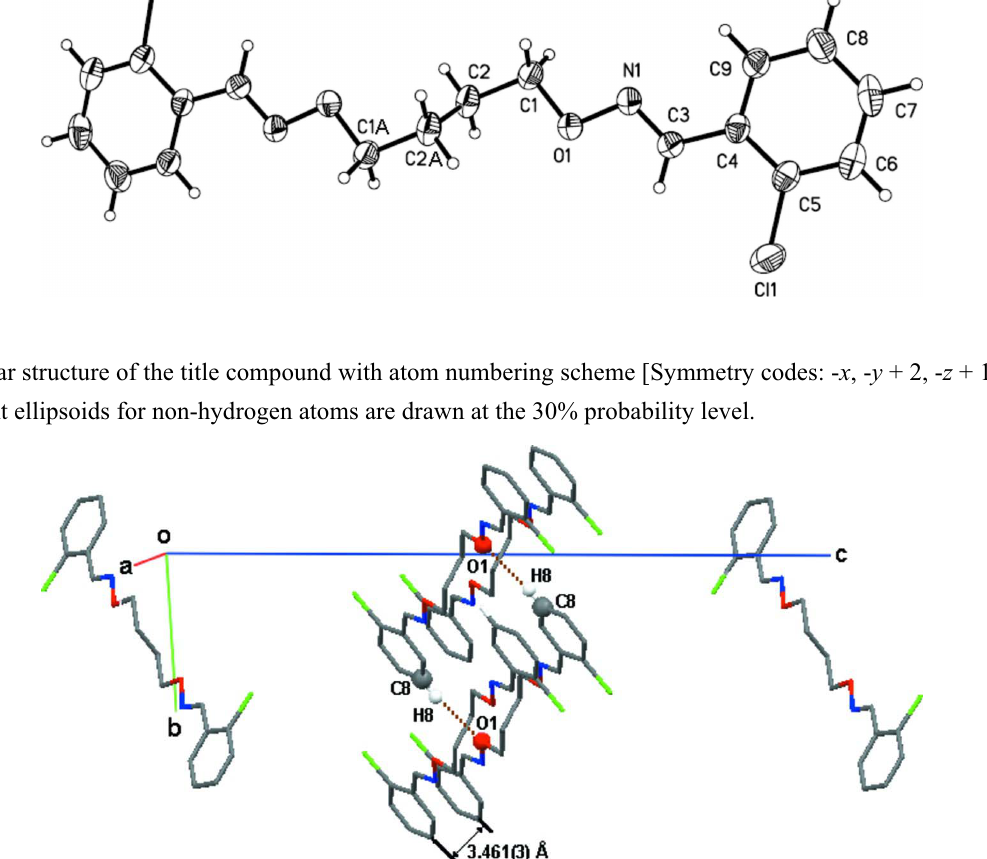
The packing diagram of the title compound showing intermolecular hydrogen bonds and π - π stacking